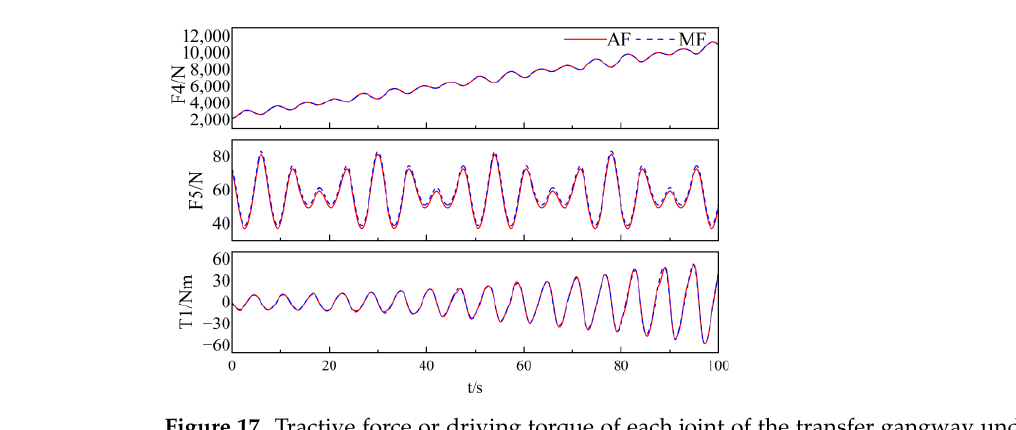
Figure 16. Tractive force of each drive support chain of the stable platform under under personnel mass of 100 kg.